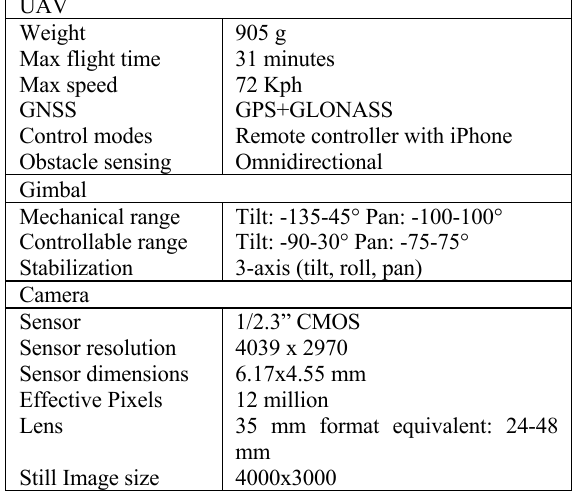
Table 2. Mavic 2 Zoom specification